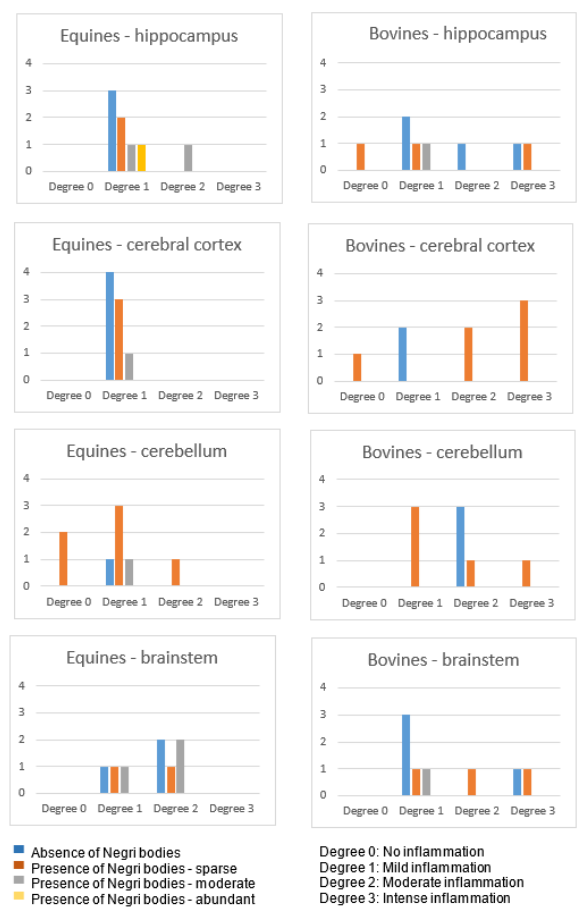
Figure 2. Correlation between the degree of inflammation and the presence of Negri bodies in fragments of hippocampus, cortex, cerebellum and brainstem from Equines and Bovines naturally infected with rabies